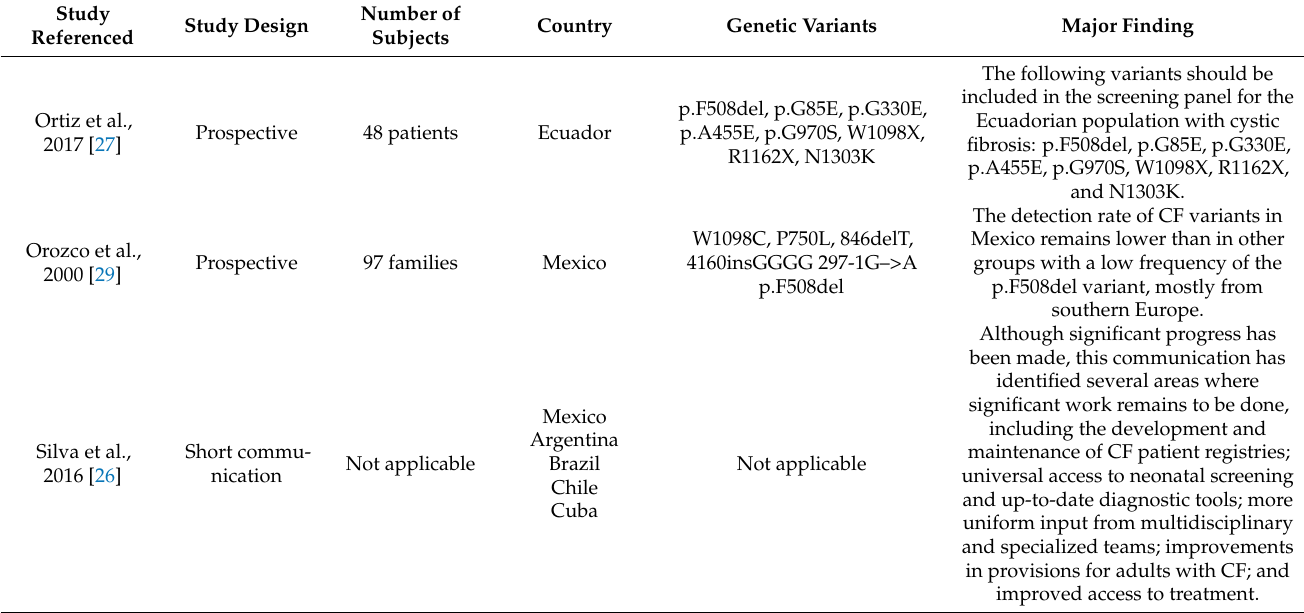
Table 6. Summary of published studies evaluating CFTR variants in Latin